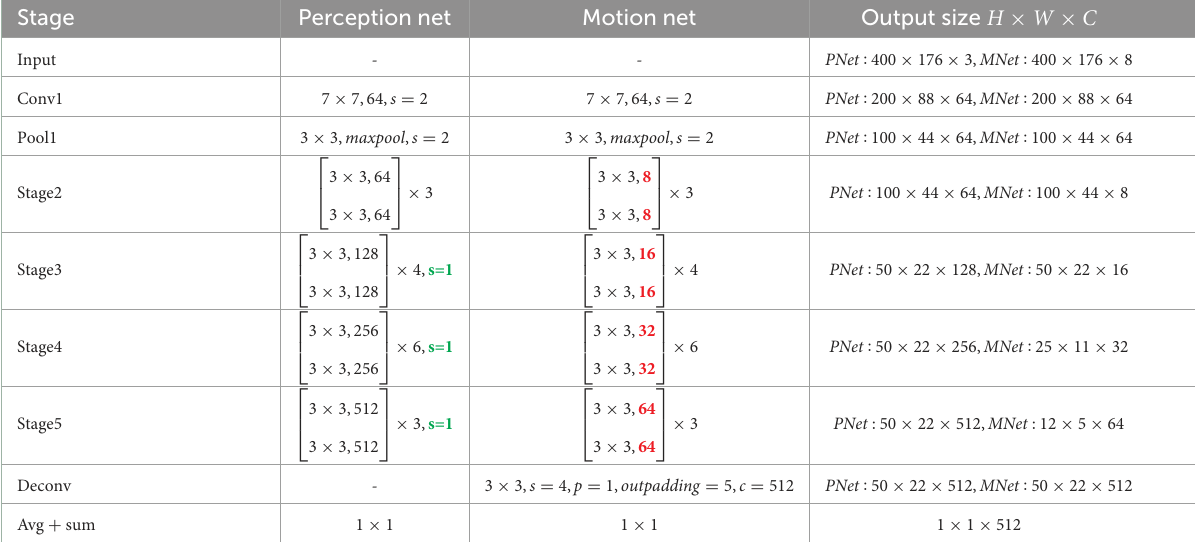
TABLE 1 Details of the structure of the dual-flow network framework.